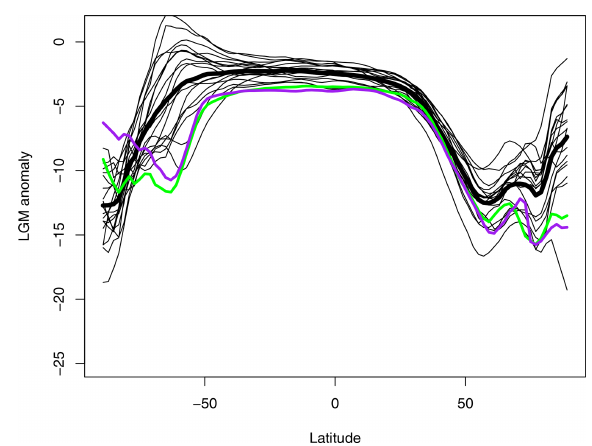
Figure 6. Latitudinal temperature anomalies. Thin black lines show the ensemble members excluding the CESM1-2-derived member. The green line shows the CESM1-2-derived member. The thick black line shows the posterior ensemble mean. The purple line shows the TEA20 posterior mean